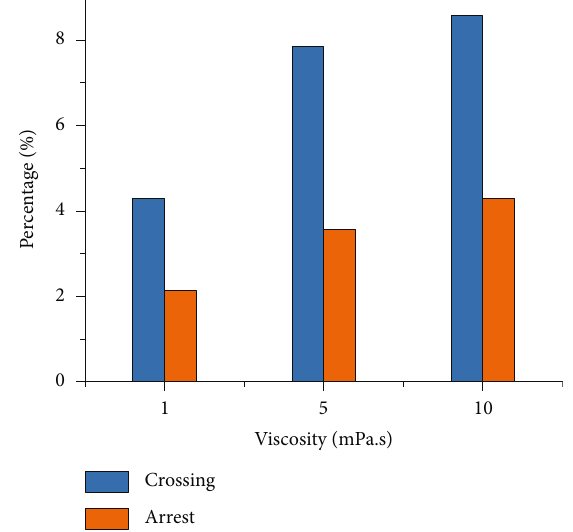
Figure 21: Numbers of events that hydraulic fractures are crossing and arrested by natural fractures for di ff erent fl uid